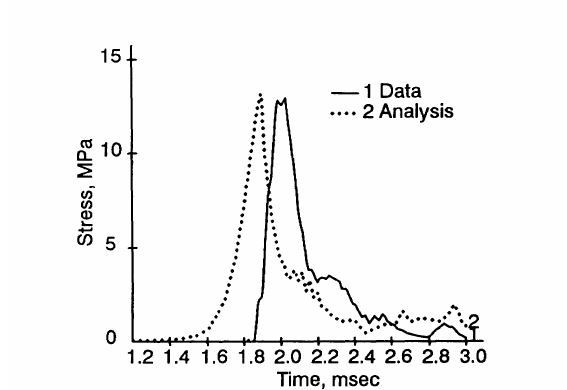
FIGURE 13 Early time interface stress near center.